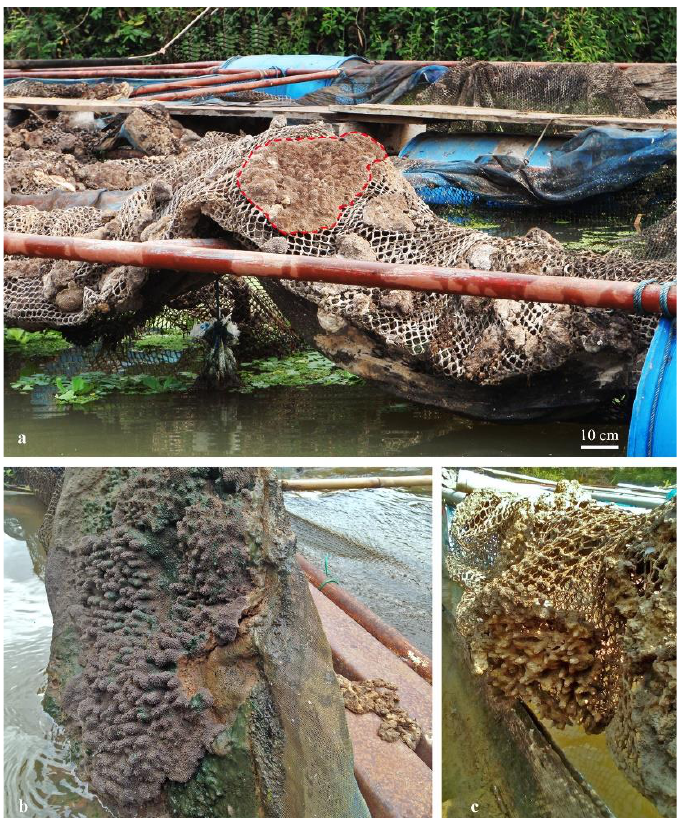
Figure 9. Dense assemblage of freshwater sponges with massive, irregular growth form as engineering species on farm nets in the Pong River (Lower Mekong, Southeast Asia). ( a ) The red area outlining the body of Corvospongilla siamensis is ~800 cm 2 . ( b ) Living Corvospongilla sp. with associated algae. ( c ) Dry freshwater sponges on net.